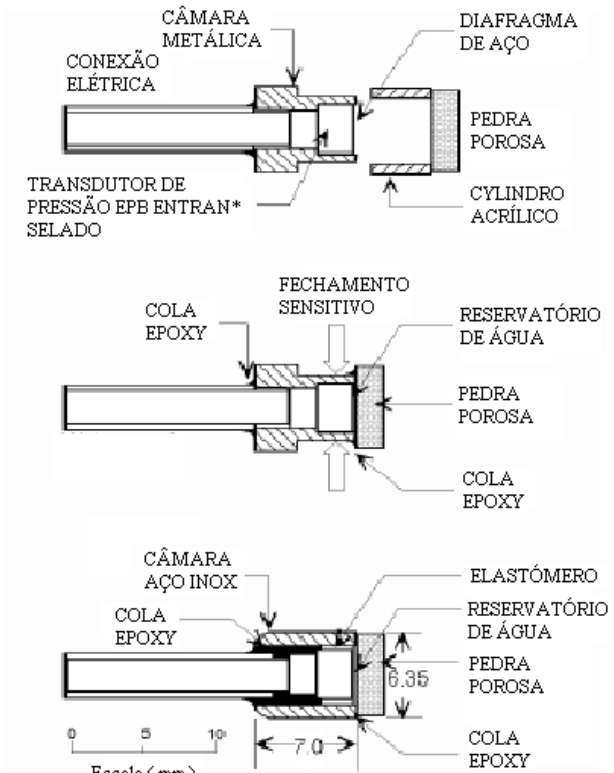
2002)Figura 6. Tensiômetro desenvolvido na Cambridge University – Inglaterra. Take & Bolton